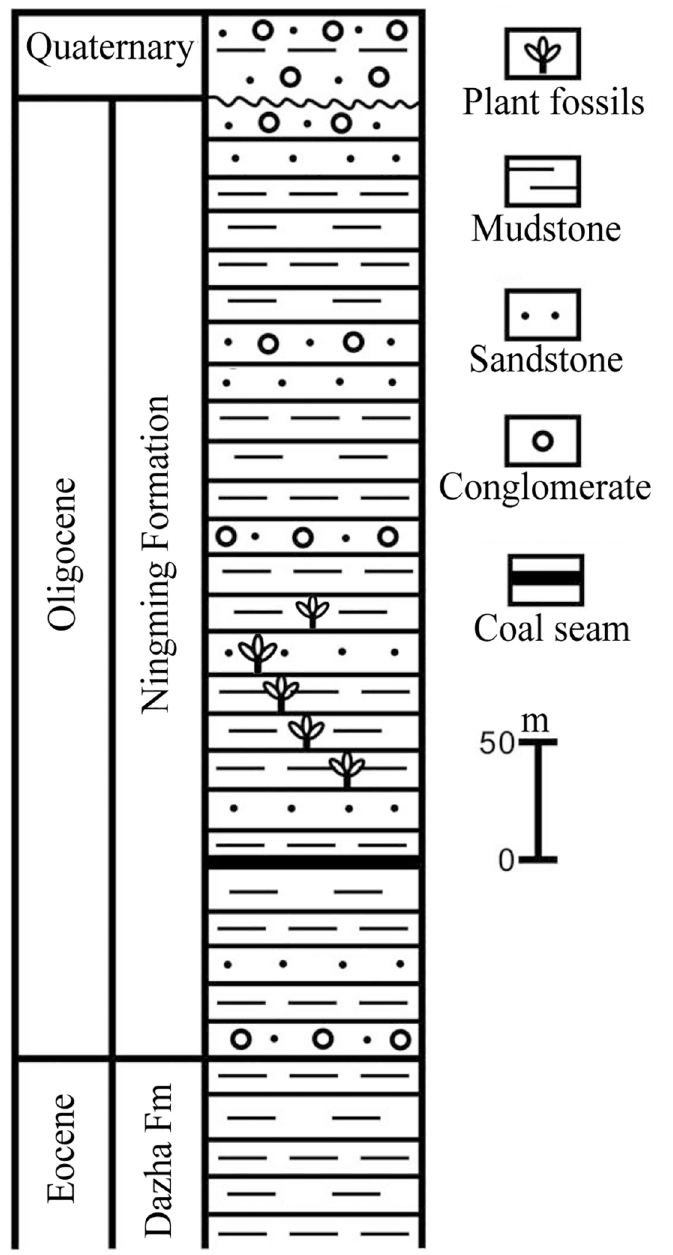
Fig 2. Generalized stratigraphic section of the Ningming Formation (after